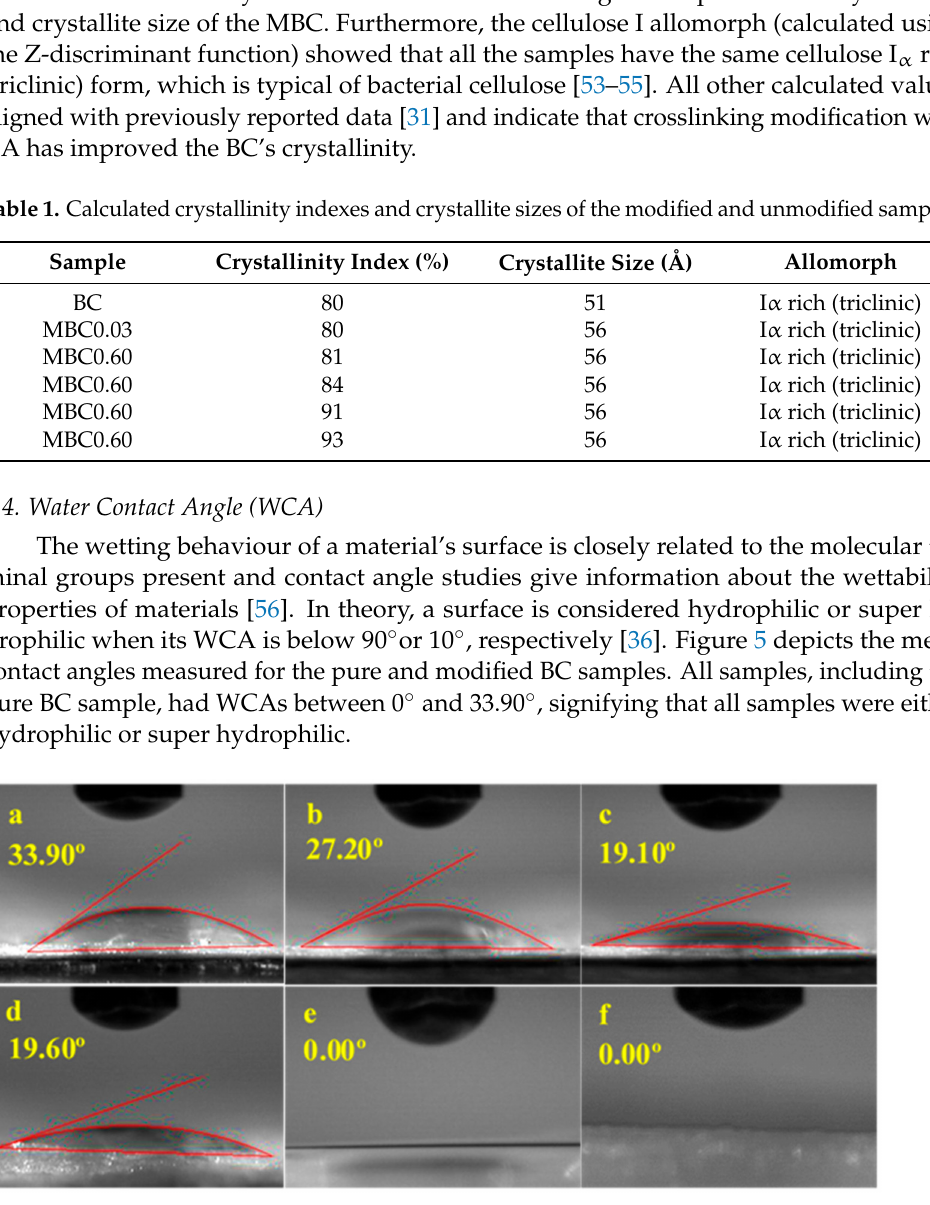
Figure 5. Mean water contact angles obtained for ( a ) BC, ( b ) MBC0.03, ( c ) MBC0.07, ( d ) MBC0.15, ( e ) MBC0.30, and ( f )